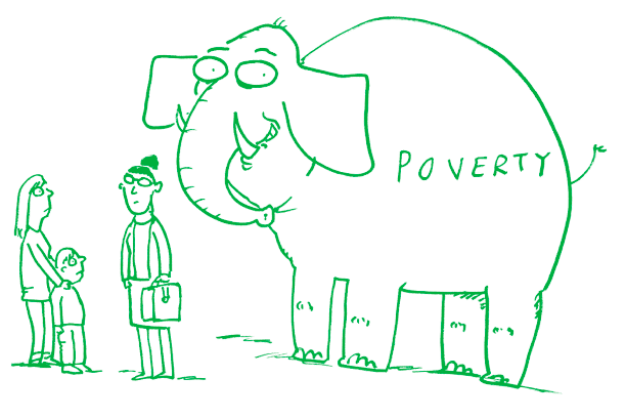
Figure 1. Poverty—the elephant in the room. Cartoon courtesy of Harry Venning.